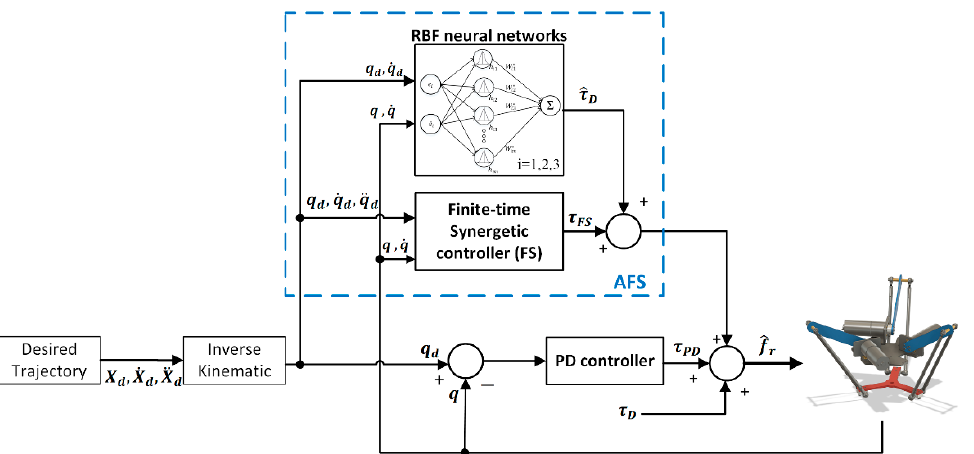
Figure 5. The Delta robot model in this paper.